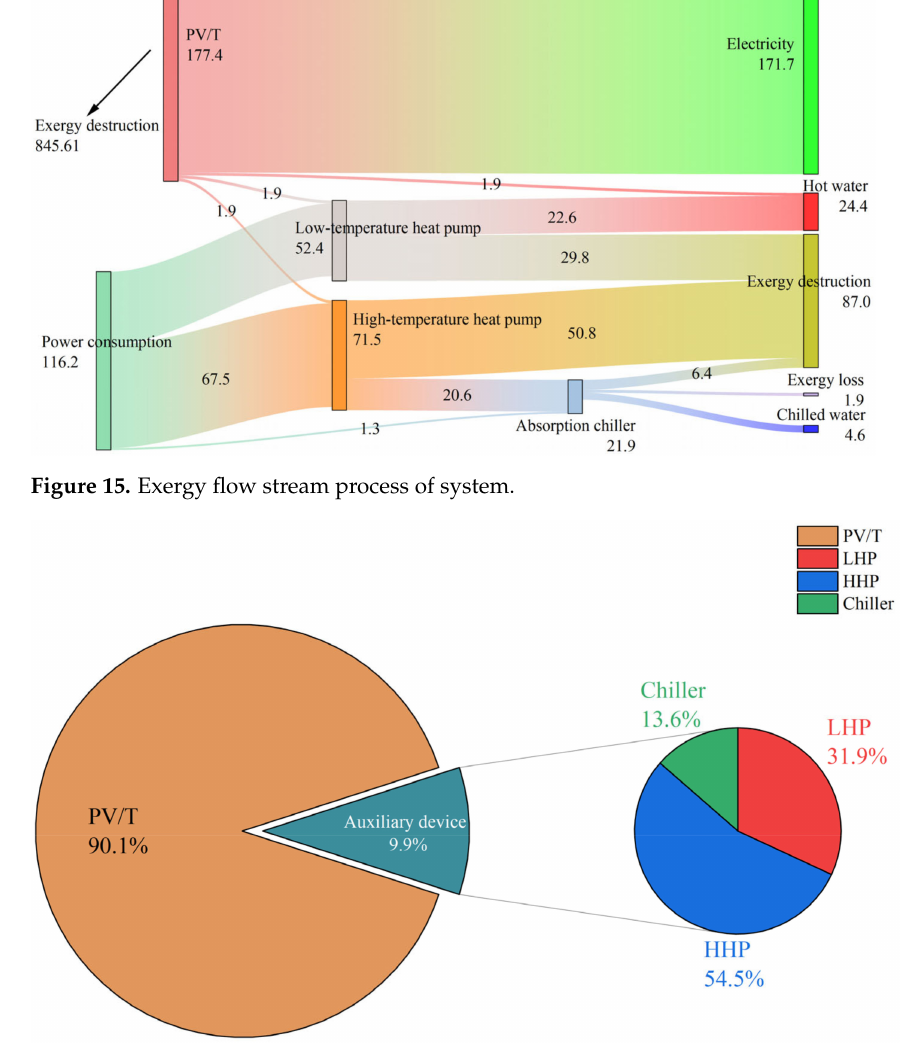
Figure 16. Proportion of exergy destruction of